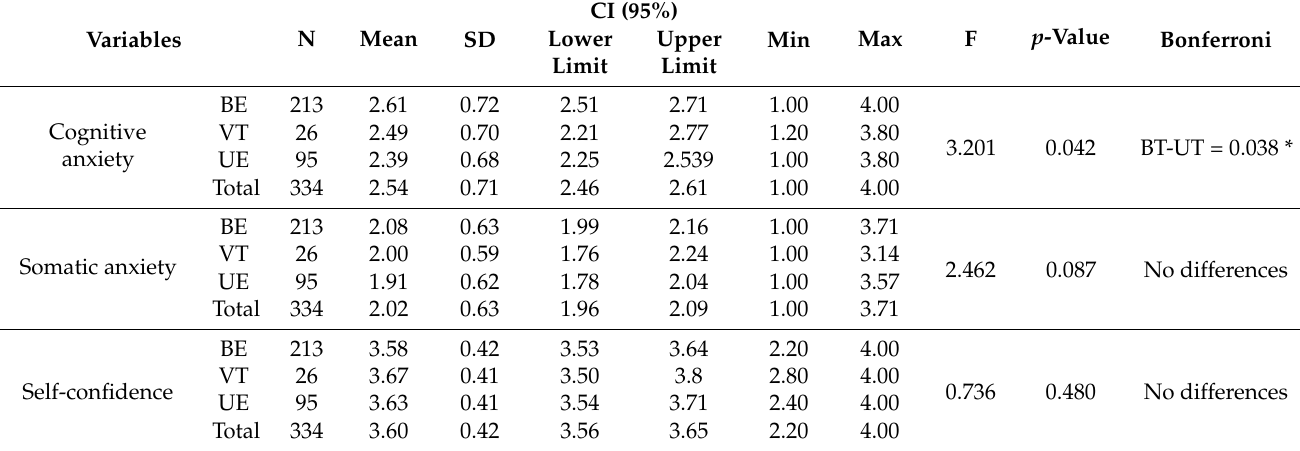
Table 8. Differences by educational